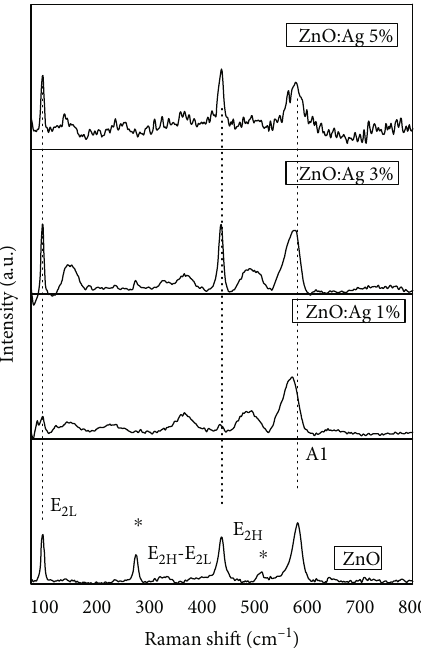
Figure 2: Raman spectrum for both the ZnO and ZnO:Ag thin fi lms. The Raman vibration modes are shown in the fi gure, where ∗ corresponds to defects inside the ZnO structure.